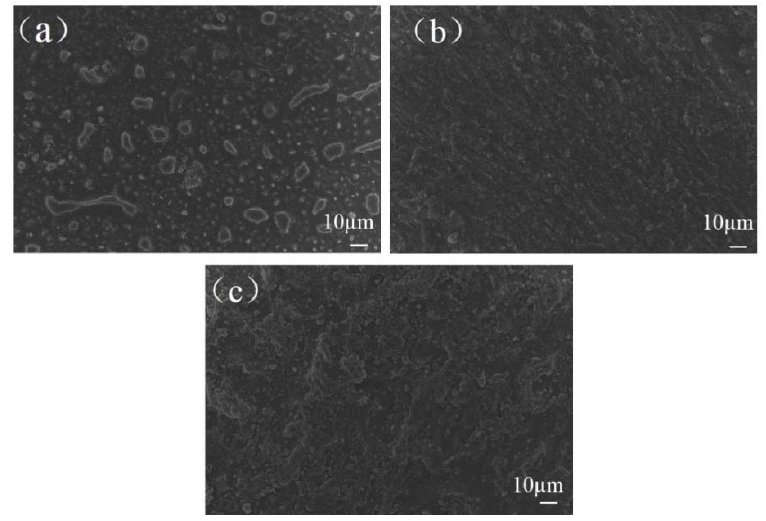
Figure 12. Surface morphologies of the PI dielectrics area after discharge aging: un-fluorinated PI ( a ), 30 min fluorinated PI ( b ), 60 min fluorinated PI ( c ).